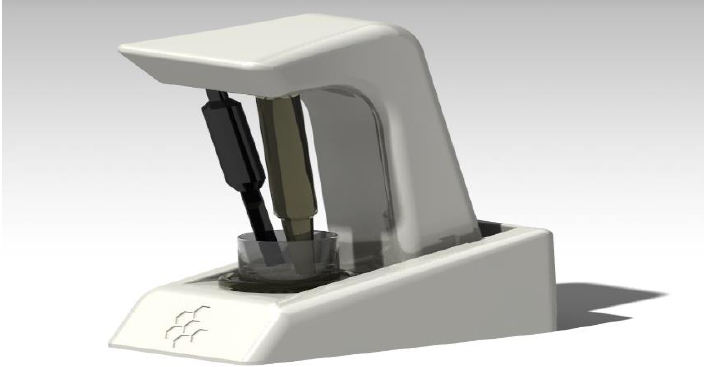
Figure 1. Photography of the PAOT-Liquid ® Technology device showing both reference and working microelectrodes immersed in the reaction medium containing free radical mediator M • and antioxidants or wines samples.